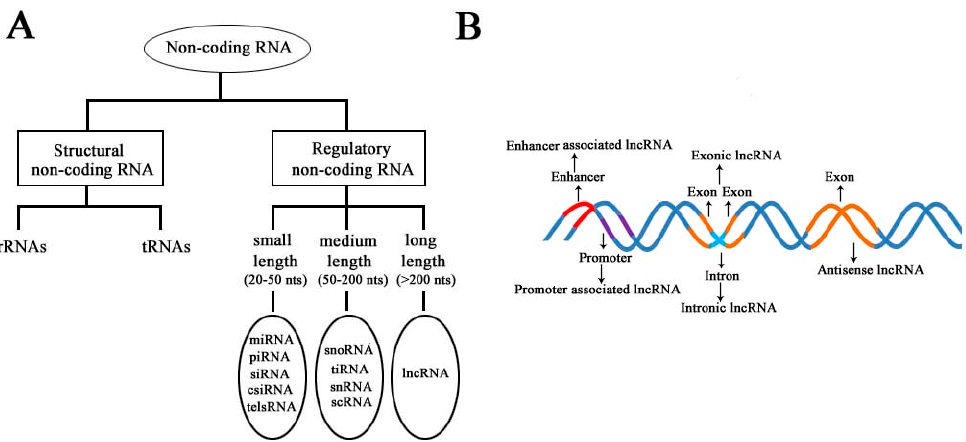
Figure 1. Schematic diagram to illustrate the diversity of long noncoding RNAs (lncRNAs) in the mammalian genome. ( A ) Classification of noncoding RNAs according to their size and function. ( B ) Overview of the biogenesis of various lncRNAs through different mechanisms. Different colors indicate different regions of DNA elements in the mammalian genome.